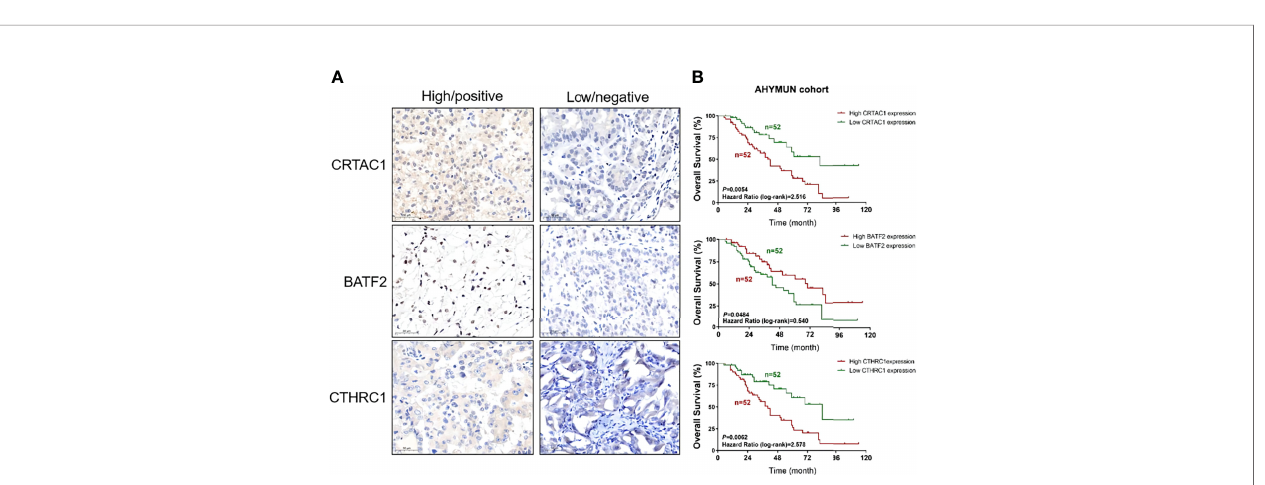
FIGURE 13 | Test of the signature by experiment and AHYMUN cohort. (A) Immunohistochemical results of STAD. (B) Survival of CRTAC1, BATF2 and CTHRC1 with different expression levels in AHYMUN